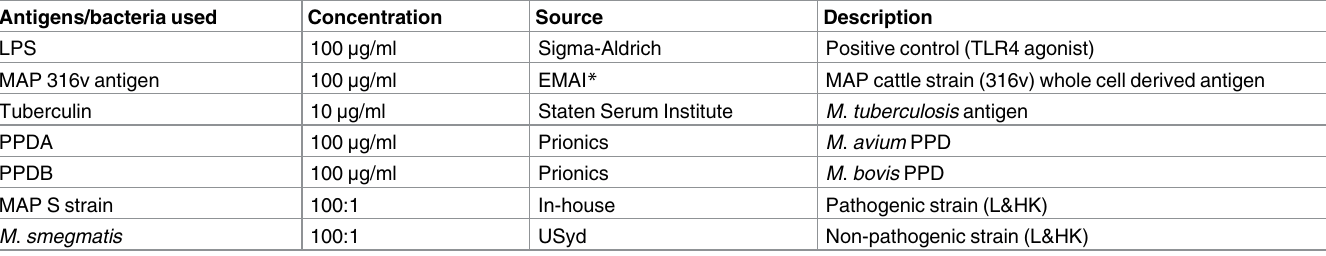
Table 1. Antigens and mycobacterial strains used for antigenic stimulation of macrophage cultures. Antigens/bacteria used Concentration Source